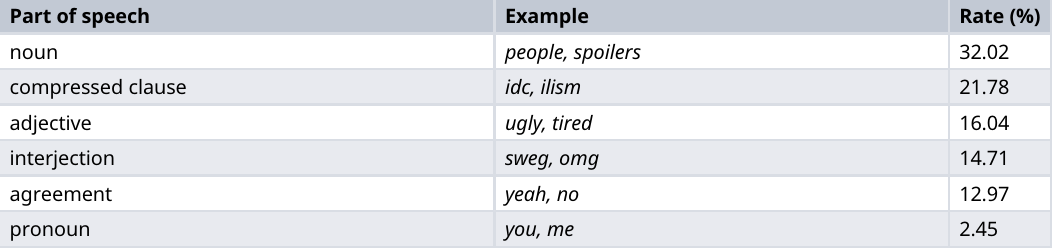
Table 1. Grammatical categories in the X-slot (based on Schnoebelen